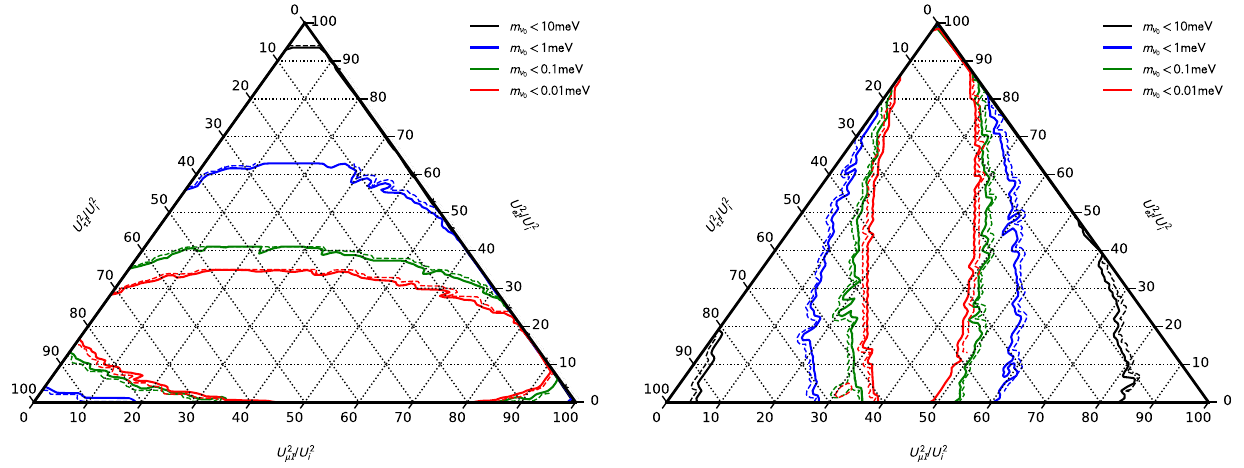
/ U 2 Fig. 11 U 2 α (in percent) for different upper limits of m ν I I and inverted hierarchy (right). As discussed in footnote 12, these constraints apply to those heavy neutrinos that can be found